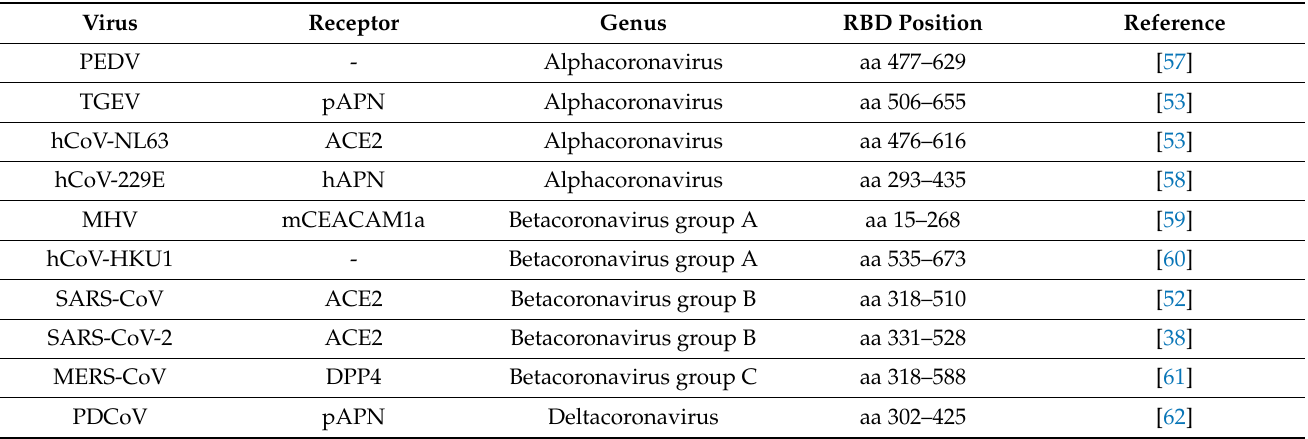
Table 2. Positions of the RBDs of some coronavirus binding